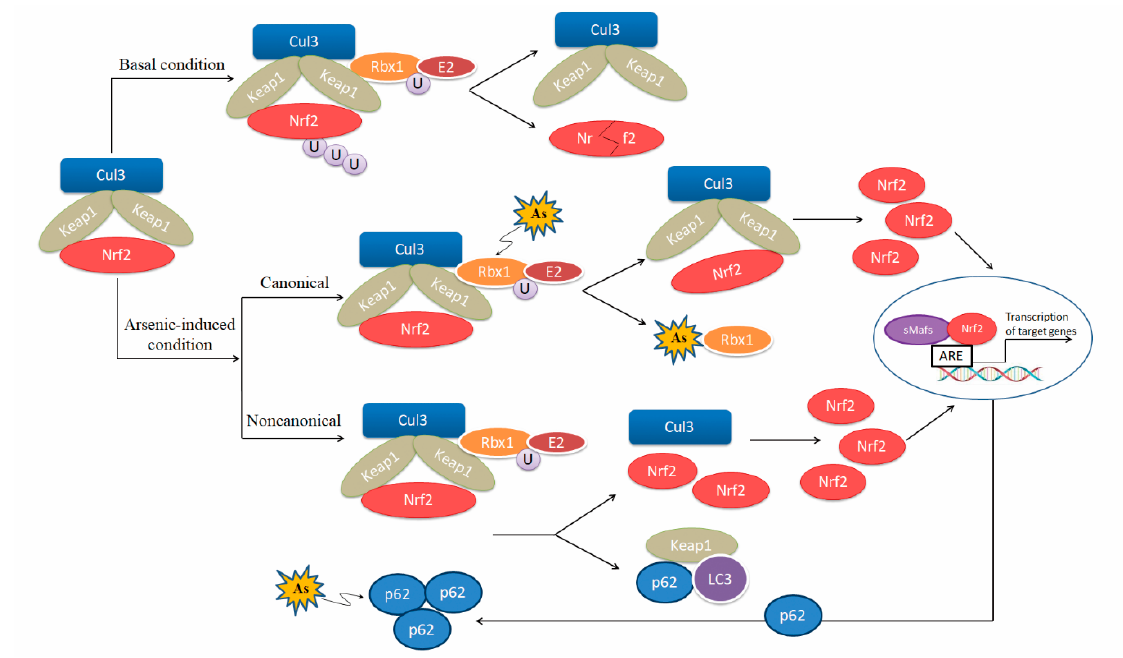
Figure 2. Regulatory models of the Nrf2-ARE pathway induced by arsenic. Under basal condition, Nrf2 is associated with Keap1 and degraded by proteasomes. Under arsenic-exposed condition, Nrf2 is activated via the canonical and noncanonical mechanisms. Arsenic binds to the Ring finger domain of RING-box 1 (Rbx1), which leads to the suppression of Cul3-Rbx1 E3 ubiquitin ligase activity, thereby activating the Nrf2-induced antioxidant signaling pathway via the canonical mechanism. Arsenic induces Nrf2 activation via the noncanonical mechanism by p62 accumulation due to dysregulated autophagy flux. p62 is a downstream gene of Nrf2, forming a positive feedback loop with Nrf2.